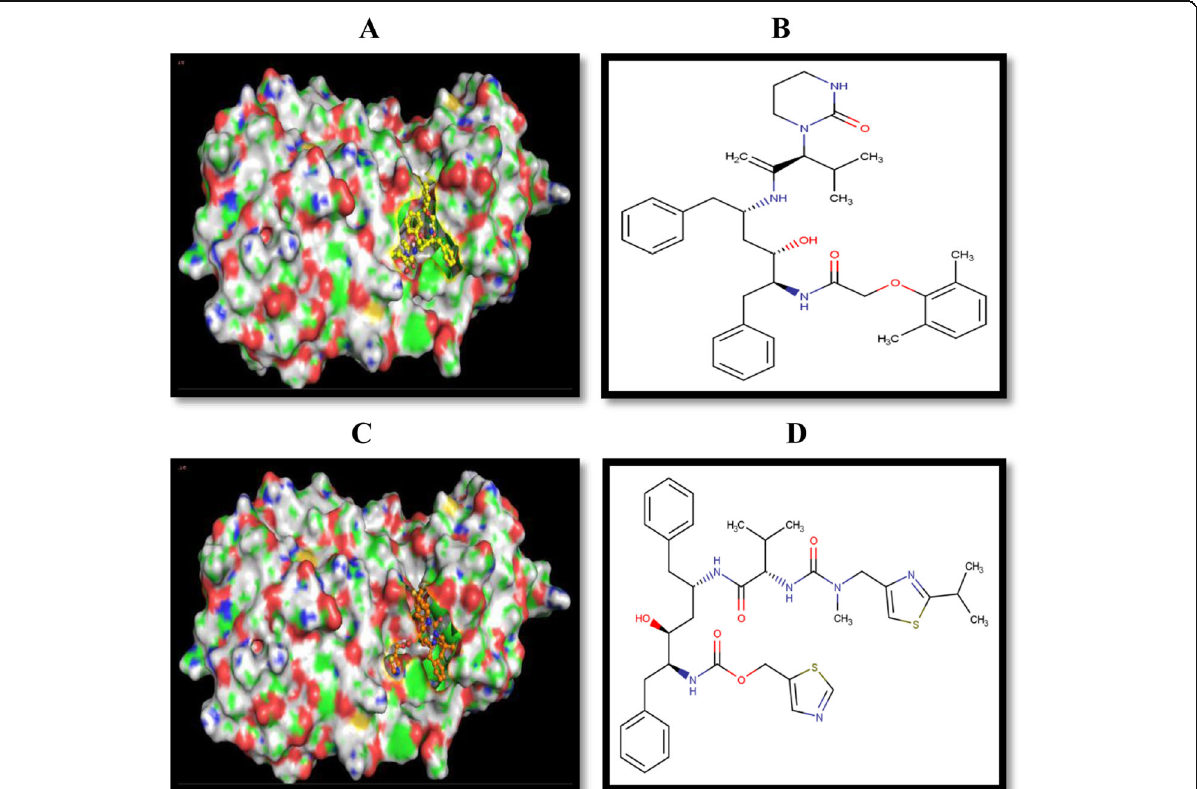
Fig. 11 a , c The induced fit binding of lopinavir and ritonavir respectively to the target protein active site while b and d show their respective 2D